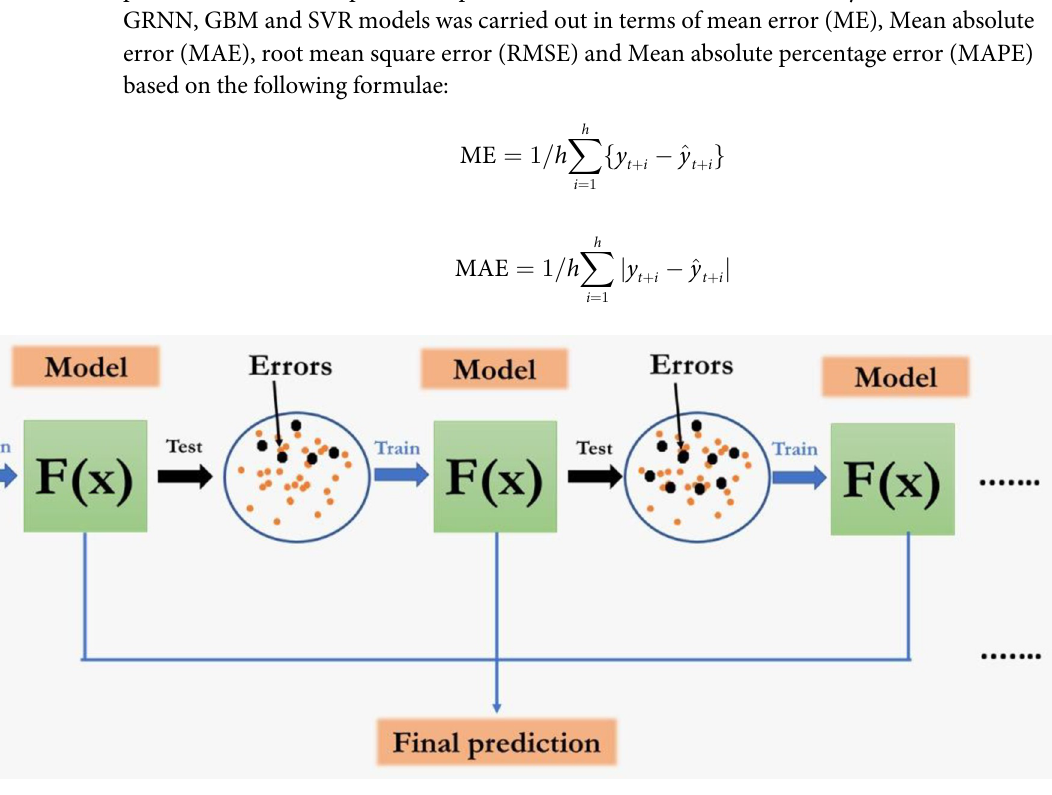
Fig 5. The sequential procedure in